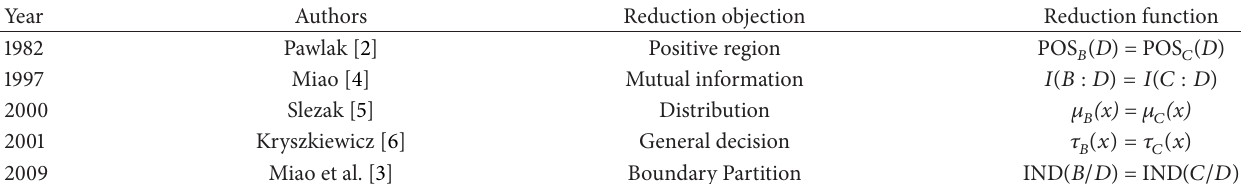
Table 3: Five different reduct objections.